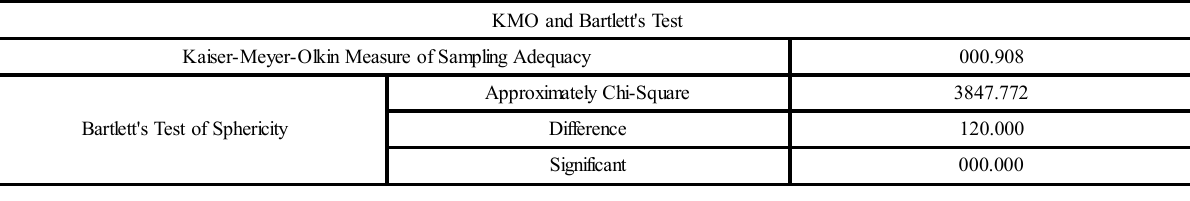
TABLE 8. RESULTS OF KMO & BARTLETT’S